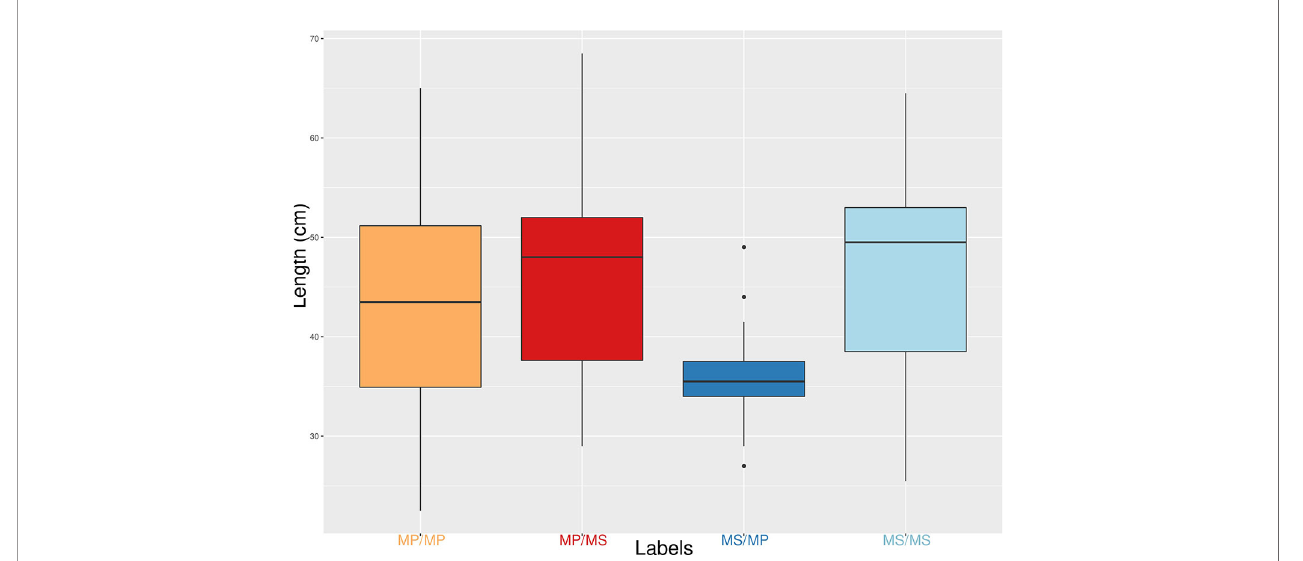
FIGURE 4 | Box and whiskers plot showing sample sizes (individual length) in each labelling category. MP/MP: samples labelled as M . polli and DNA-assigned to M. polli (orange) ; MP/MS: samples labelled as M . polli and DNA-assigned to M. senegalensis (red) ; MS/MS: samples labelled as M . senegalensis and DNA-assigned to M. senegalensis (light blue) ; MS/MP: samples labelled as M . senegalensis and DNA-assigned to M. polli